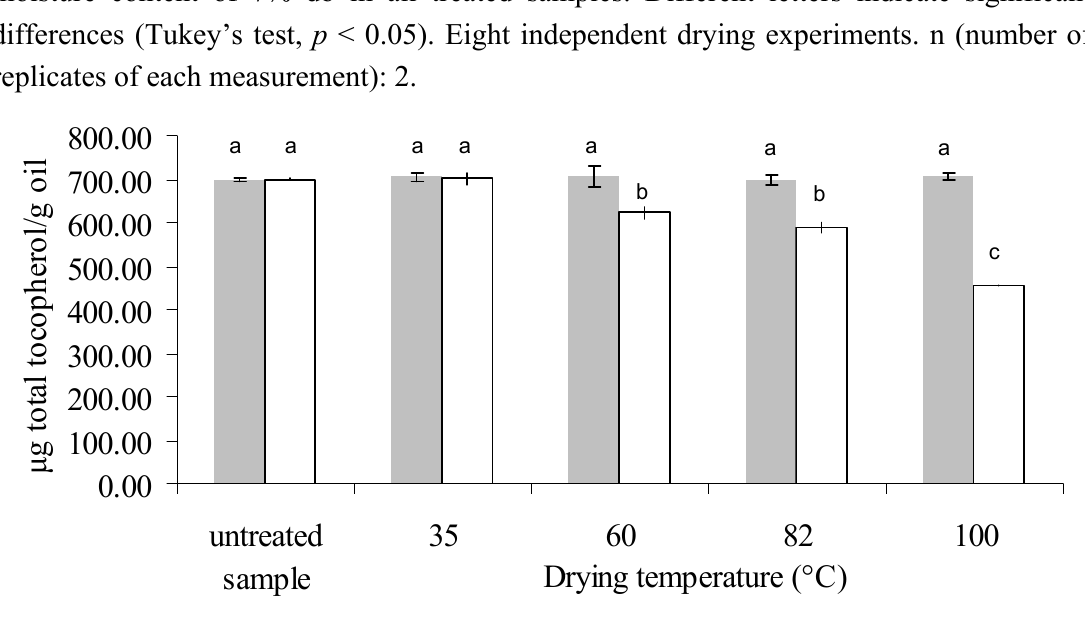
Figure 3. Alpha-tocopherol concentration in the oil extracted from untreated and treated samples of canola, at an initial moisture level of 13.6% db ( ■ ) and 22.7% db ( □ ) and final moisture content of 7% db in all treated samples. Different letters indicate significant differences (Tukey’s test, p < 0.05). Eight independent drying experiments. n (number of replicates of each measurement):